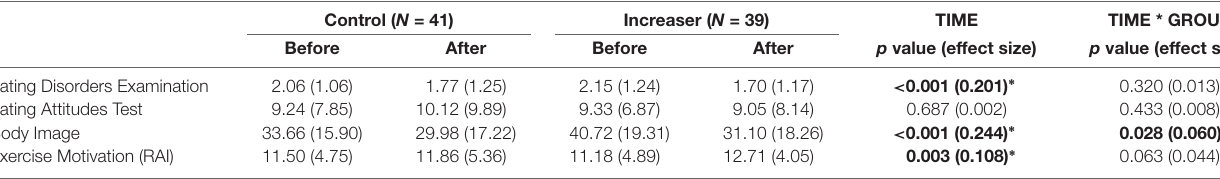
TABLE 4 | Eating attitudes, body image, and exercise motivation. Control ( N = 41) Increaser ( N = 39) TIME TIME * GROUP Before After Before After